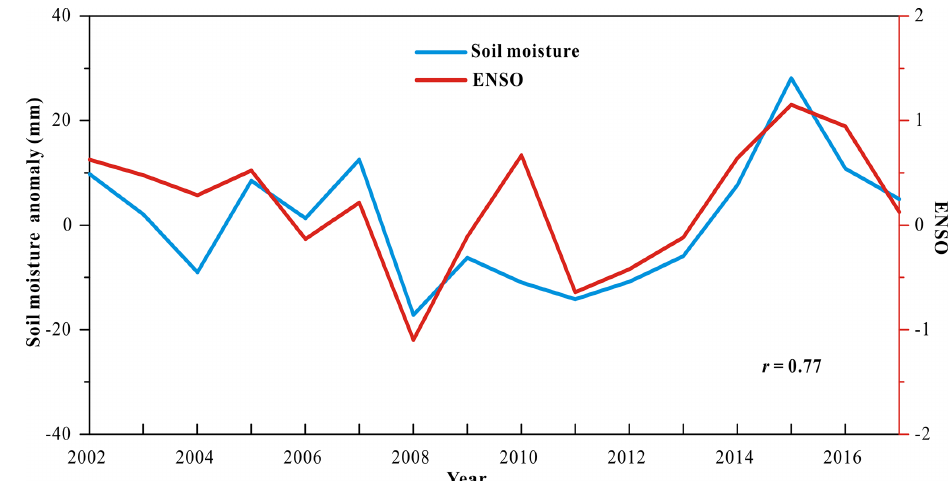
Figure 6. The residual time series of spring soil moisture and associated ENSO in region 3 during